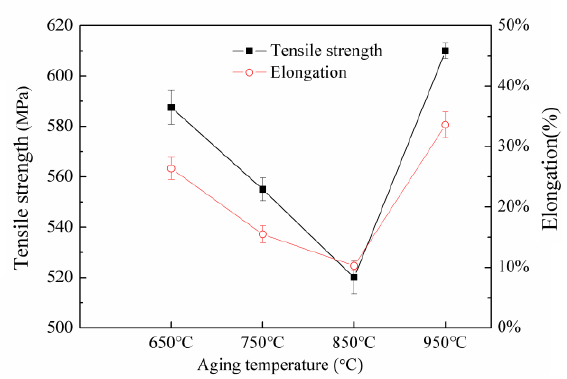
Figure 6. Tensile strength and elongation of NSSC 2120 after aging at different temperatures.